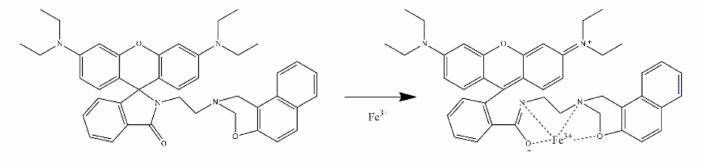
Figure 23. The proposed sensing mechanism of M3 (Table 1, No. 29) to Fe 3+ [58]. A rhodamine salicylaldehyde sensor, named RS, was constructed to modify a fluores- cent PU foam named PU-RS, as a sensitive fluorescence sensor for Fe 3+ (Table 1, No. 30) [59]. PU-RS showed ring-opened amide form and higher fluorescence intensity, due to the co- ordination between RS and Fe 3+ in pure water (Figure 24). Liu X., et al. synthesized a rhodamine-based sensor (RhBUEA) by functionalizing the polyacrylamide hydrogel through free radical polymerization of RhBUEA and then constructed a fast, visual detec- tion device for Fe 3+ (Table 1, No. 31) [60]. The fabricated hydrogel showed good